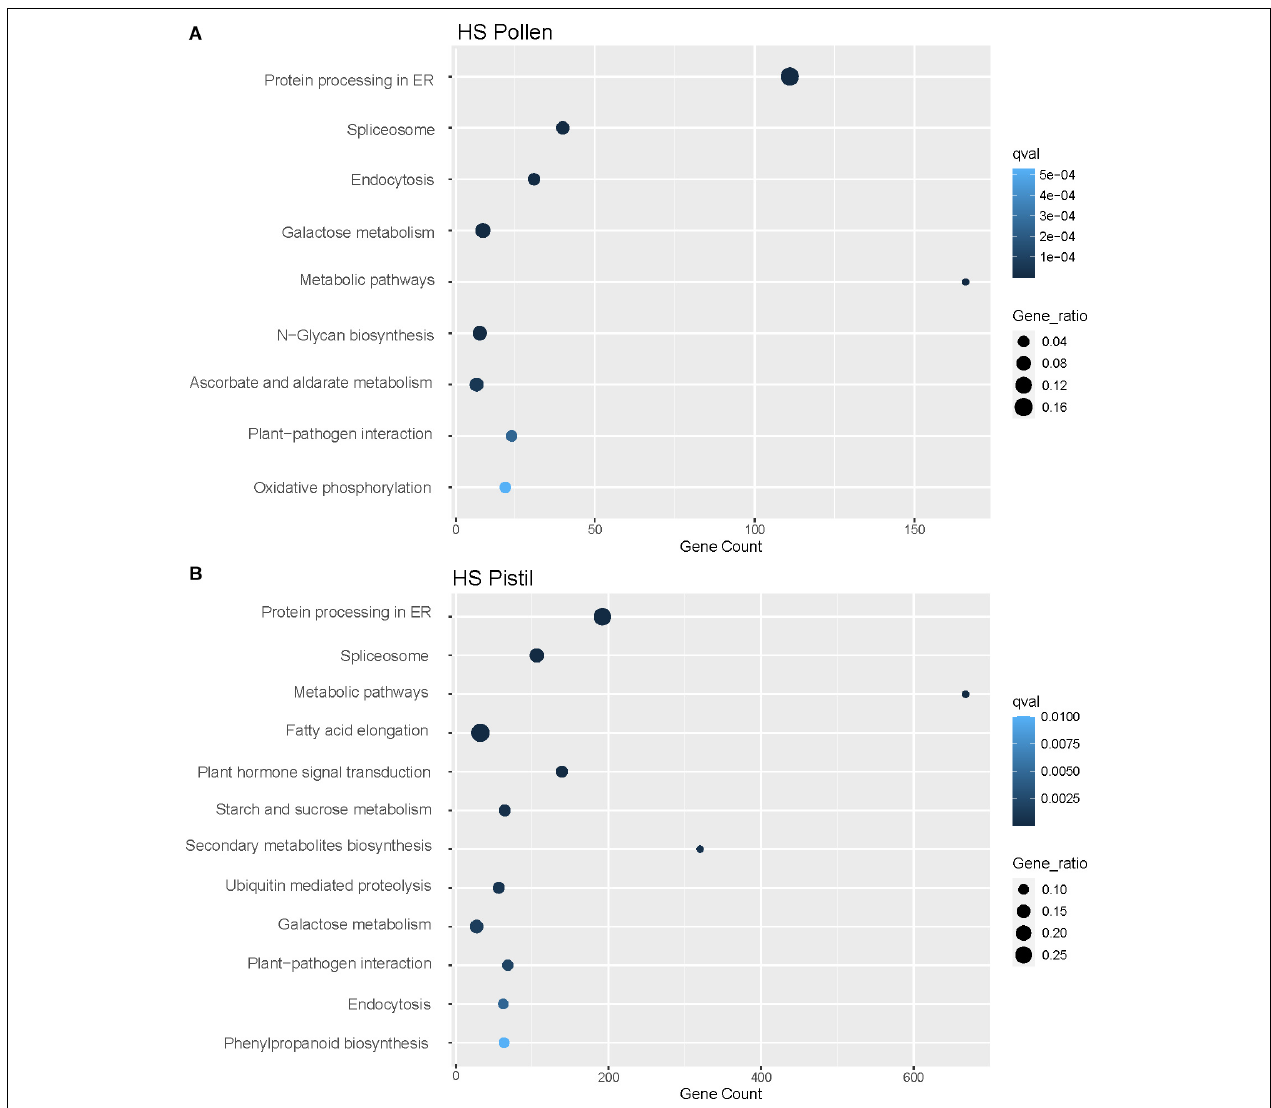
FIGURE 6 | (A) Enriched KEGG pathways ( p < 0.01) associated with the DEGs in heat-stressed (HS) pollen. (B) Enriched KEGG pathways ( p < 0.01) associated with the DEGs in heat-stressed (HS)